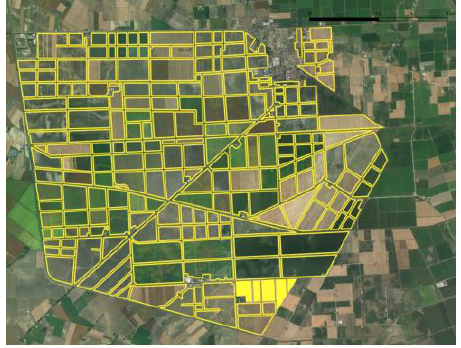
Figure 1. Jolanda di Savoia estate, the field of experiment (ID 467) is highlighted in yellow.